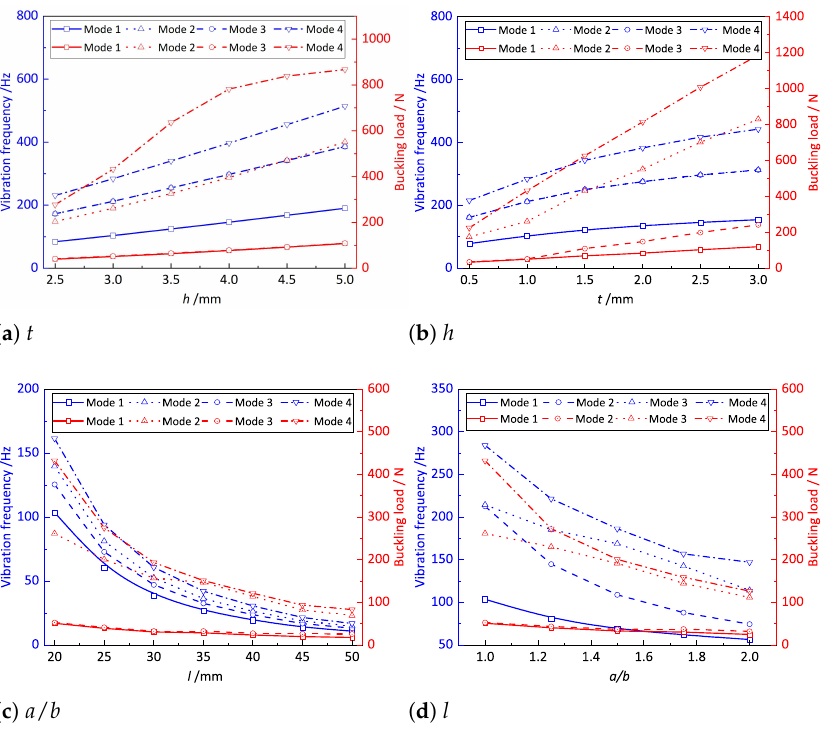
Figure 13. Effects of the structural parameters on the natural frequency and buckling load of the